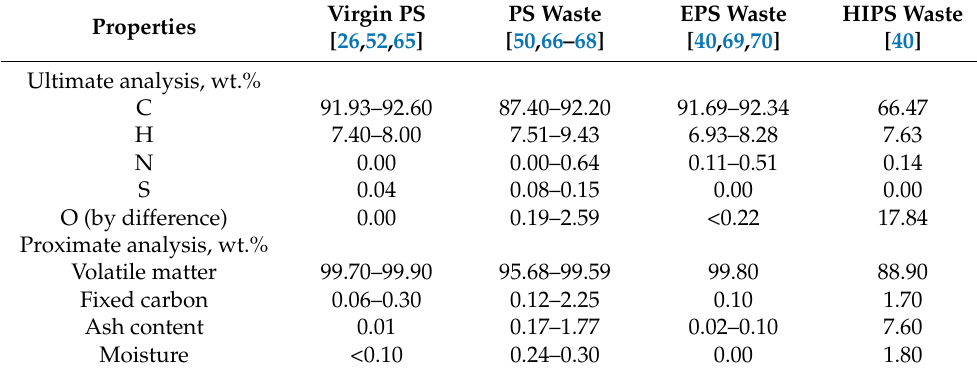
Table 1. Summary of chemical properties of different PS types.